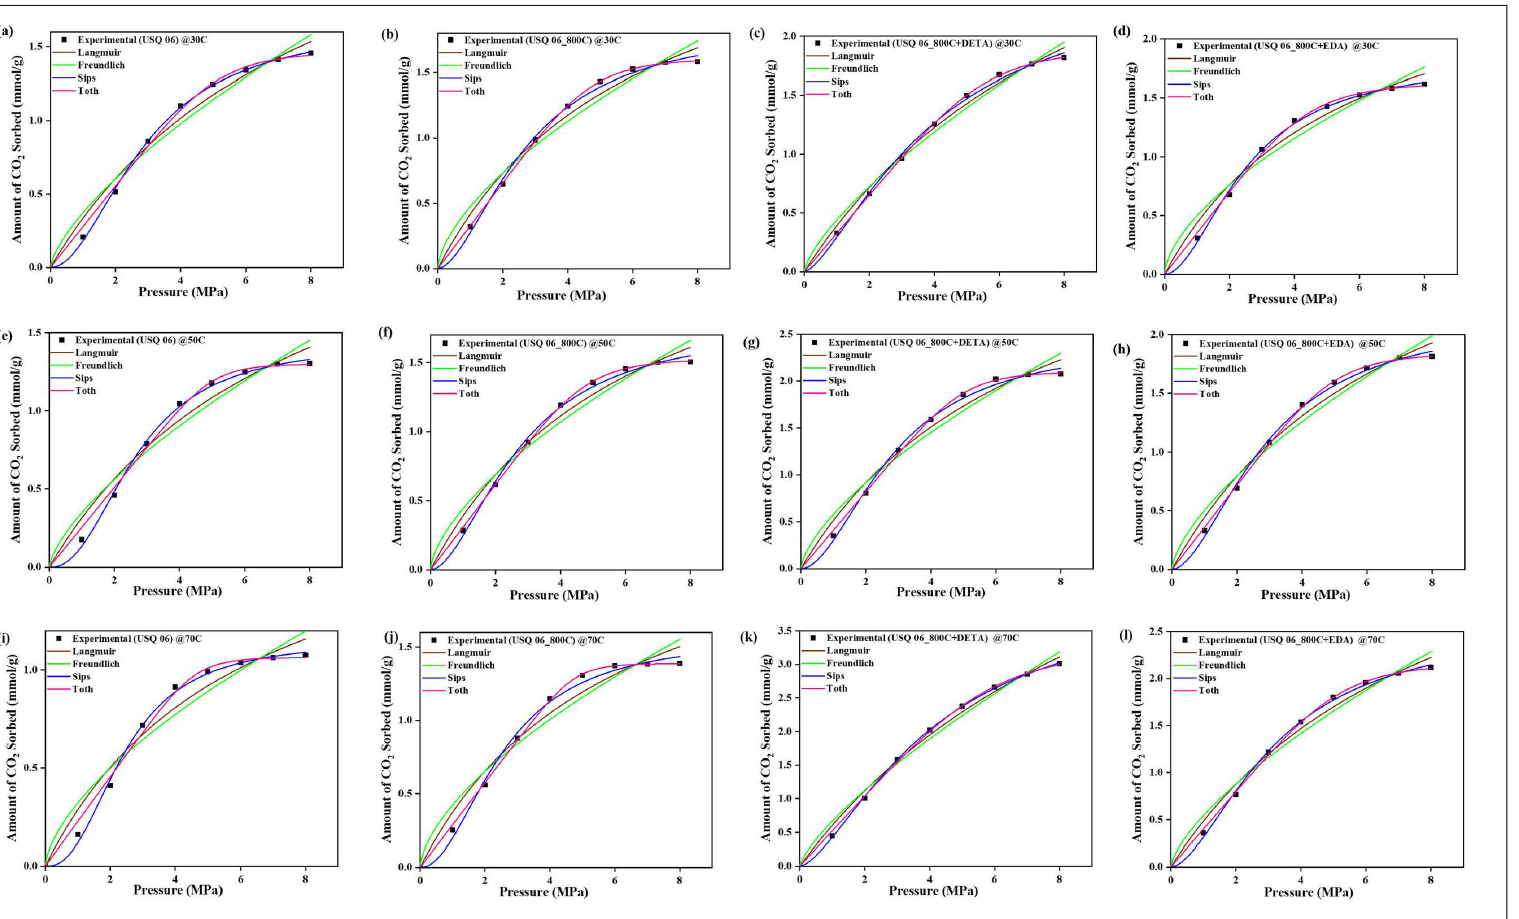
Figure 10. Prediction of the sorption behavior of USQ 06 variants with Isotherm models at temperatures 30 ◦ C ( a – d ), 50 ◦ C ( e – h ), 70 ◦ C ( i – l ), and up to 8 MPa